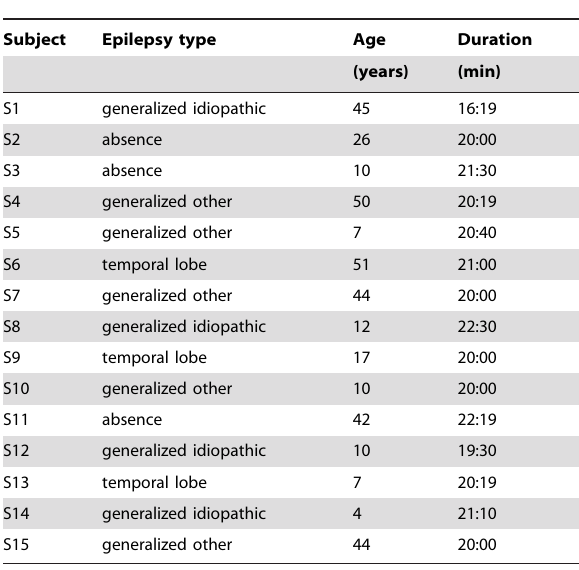
Table 1. Subject information of the EEGs used to test the detection and reviewing